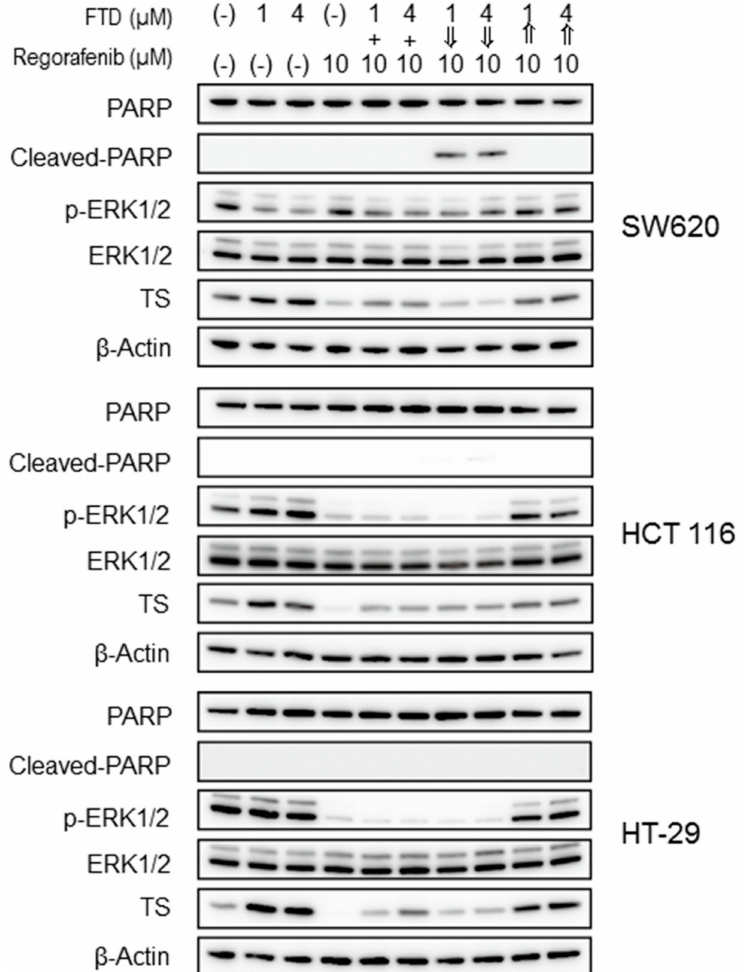
Figure 3. Effects on the expression of phosphorylated extracellular signal-related kinase (p-ERK), ERK, thymidylate synthase (TS), and markers of cell death in SW620, HCT 116, and HT-29 cells using various trifluridine (FTD) and regorafenib treatment schedules. Immunoblots after treatment with 1.0 and 4.0 µ M FTD for 24 h, 10.0 µ M regorafenib for 24 h, and simultaneous and sequential treatment with 1.0 and 4.0 µ M FTD and 10.0 µ M regorafenib using the same schedules mentioned above are shown. Definition: PARP—poly(ADP-ribose)